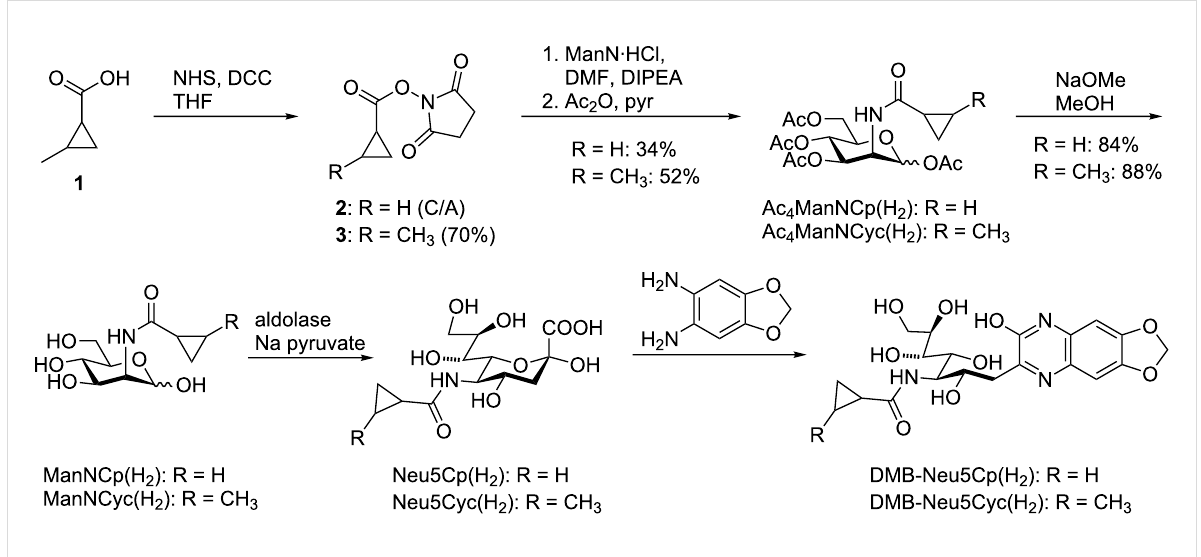
Scheme 2: Synthesis of Ac 4 ManNCp(H 2 ) and Ac 4 ManNCyc(H 2 ) and the corresponding DMB-labeled sialic acids. C/A = commercially